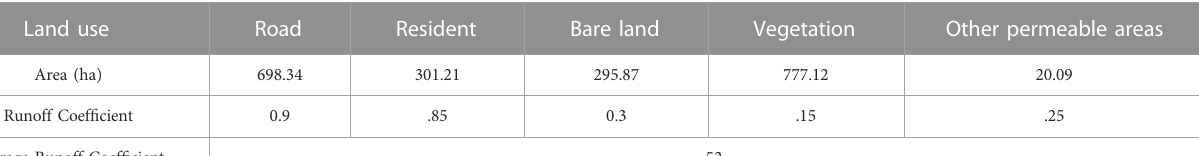
TABLE 3 The average runoff coef fi cient in the study